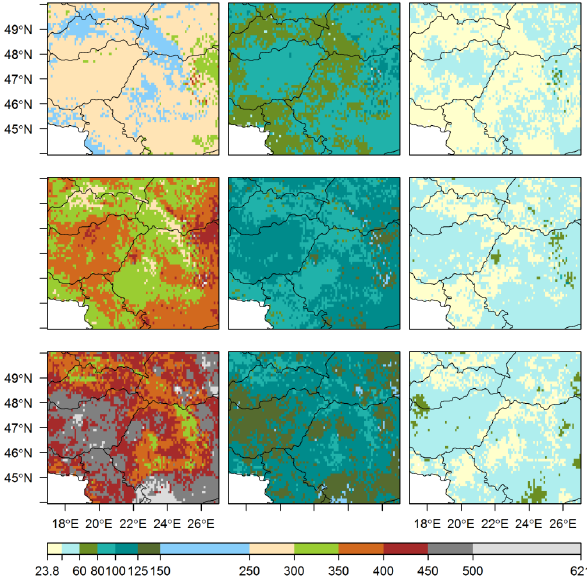
Figure 7. Climatological probability (%) of receiving the precipita- tion needed to end a (top) moderate ( − 3<Sc-PDSI ≤ − 2), (center) severe ( − 4<Sc-PDSI ≤ − 3) and (bottom) extreme drought (SC- PDSI ≤ − 4) in the next month (left), next 3 months (center) and next 6 months (right)